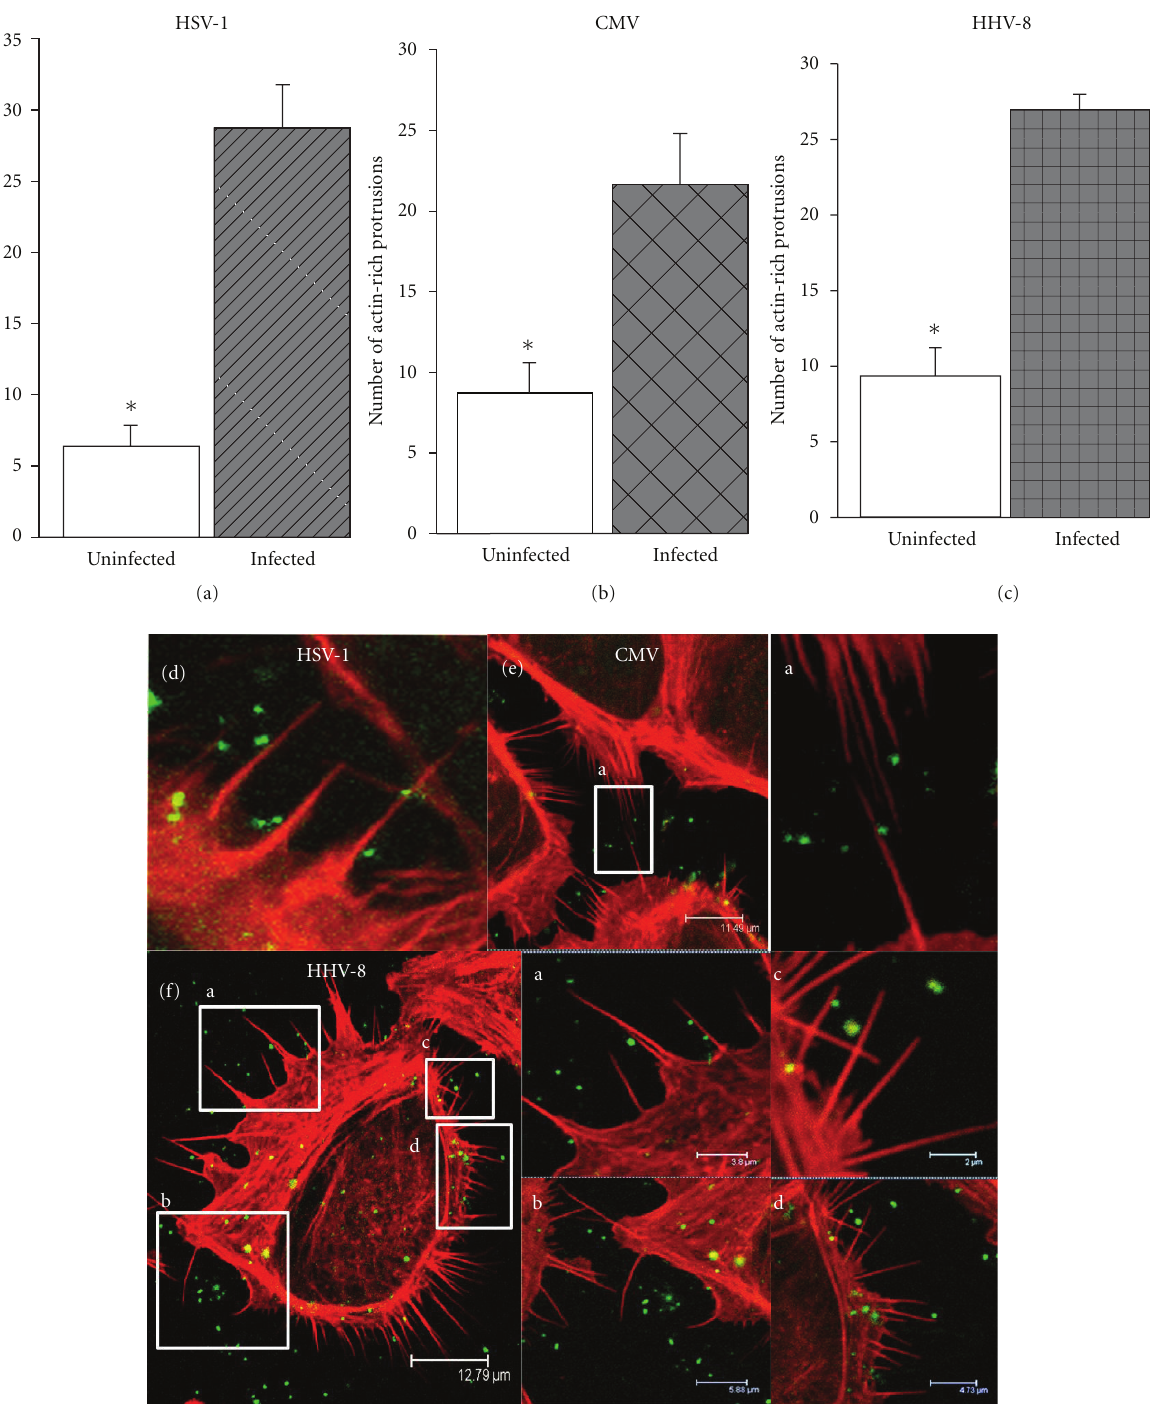
Figure 1: Herpesvirus infection leads to increase in the number of F-actin-rich projections. (a)–(c) Counting of the projections on per cell basis was done 15–30 min before and after the addition of the virus indicated (Herpes simplex virus type-1; (HSV-1), Cytomegalovirus; (CMV) and Human herpesvirus-8; (HHV-8)). In this and all other subsequent experiments cells used included corneal fibroblasts (CFs) (a) for HSV-1, human retinal pigment epithelial (RPE) cells for CMV (b), and primary cultures of human conjunctival epithelial (HCjE) for HHV-8 (c) infection. Four independent experiments were conducted to record the data. Numbers of actin-rich protrusions are presented as means with error bars showing standard deviation. (d)–(f) Confocal images of cells challenged with indicated viruses are shown. Virally infected cells were fixed, permeabilized, and stained for F-actin with 10 nM rhodamine-conjugated phalloidin before mounting (Vectashield mounting medium). All confocal (Leica SP2) images were captured at 63x objective. Magnified views of the images in the boxes are shown next to them and labeled identically. CMV and HHV-8 viruses were identified by monoclonal antibodies against CMV envelope glycoprotein gB and HHV-8 K8.1A (1:50) followed by secondary antibody treatment conjugated to